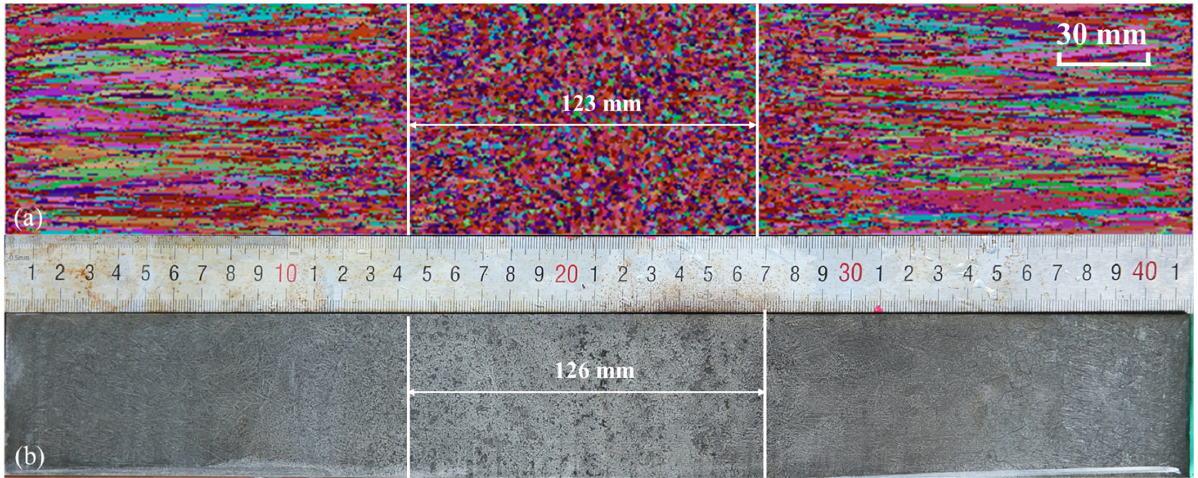
Figure 4. Comparison of numerical and experimental structure of 2311 die steel: ( a ) simulated solidification structure ( b ) experimental solidification structure.